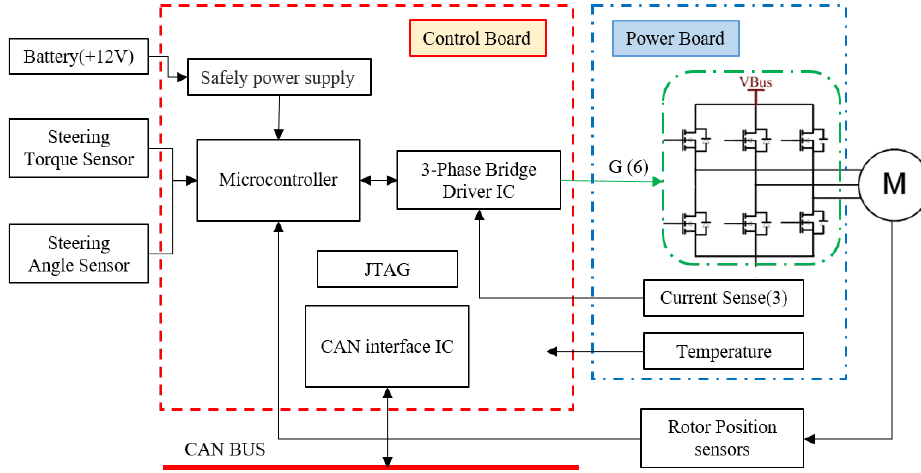
Figure 3. EPS system PMSM motor control board operating schematic.